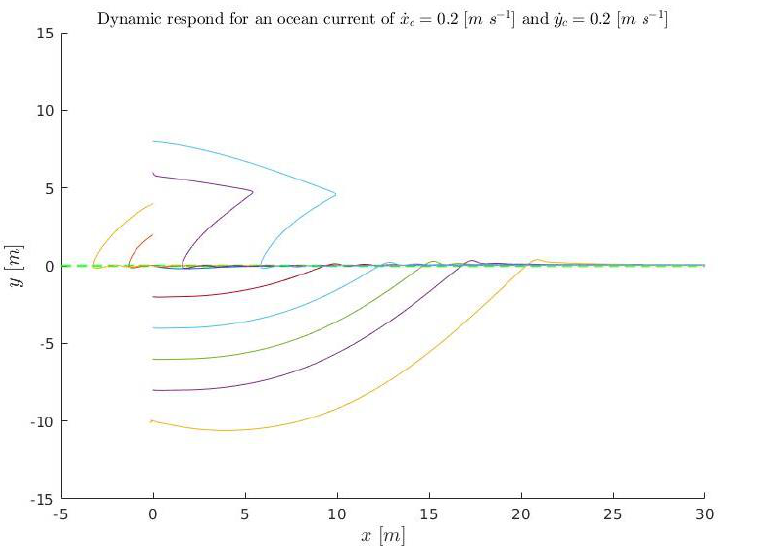
Figure 17. Dynamic simulation for the conditions (36). The colored lines represent the different simulations and the green discontinuous line the acceptance